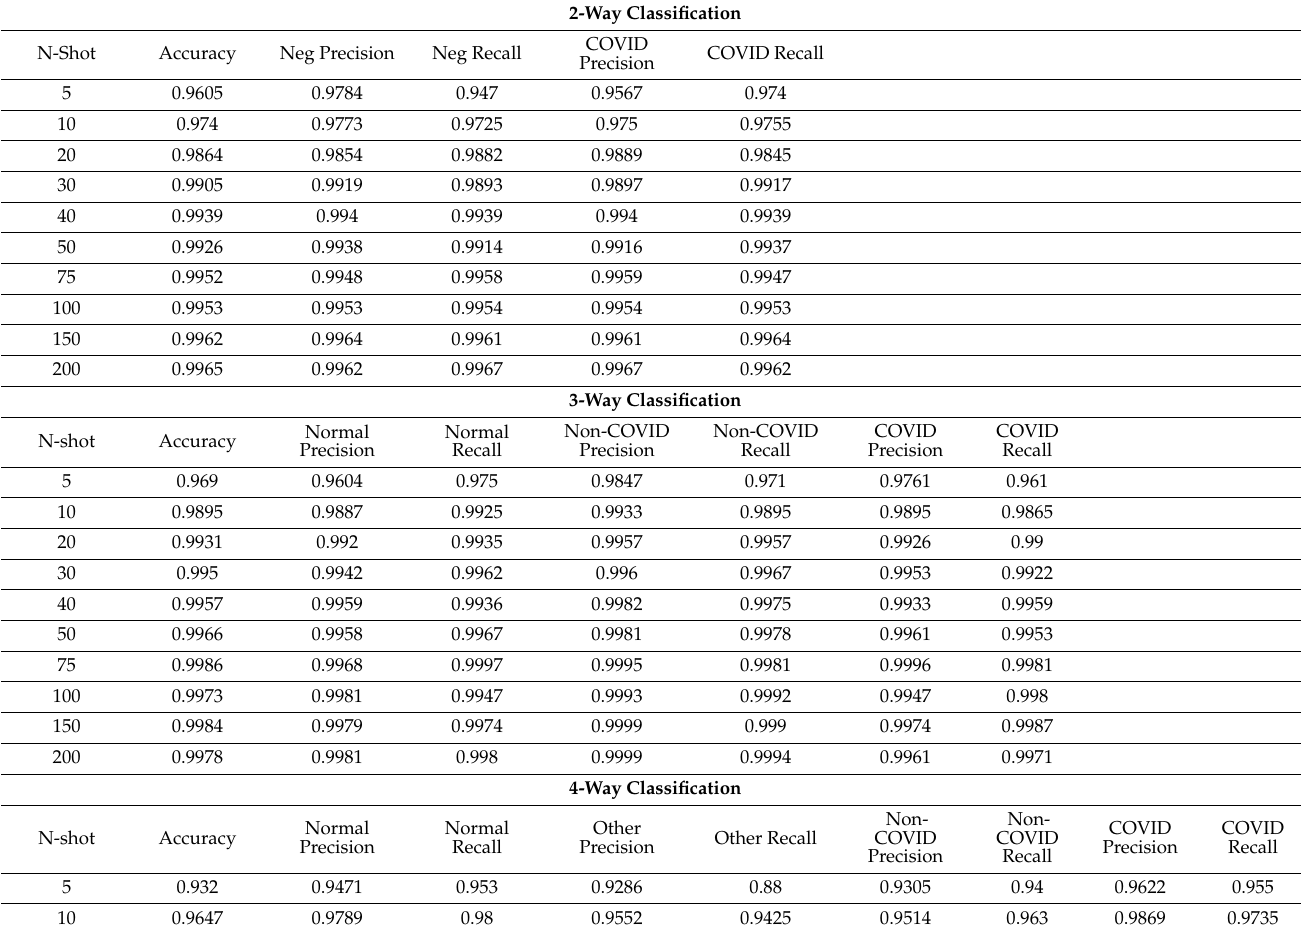
Table A5. Complete experiment results for